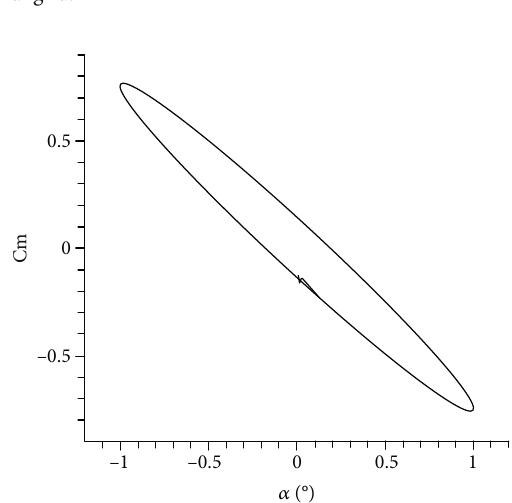
Figure 4: Computational grid.